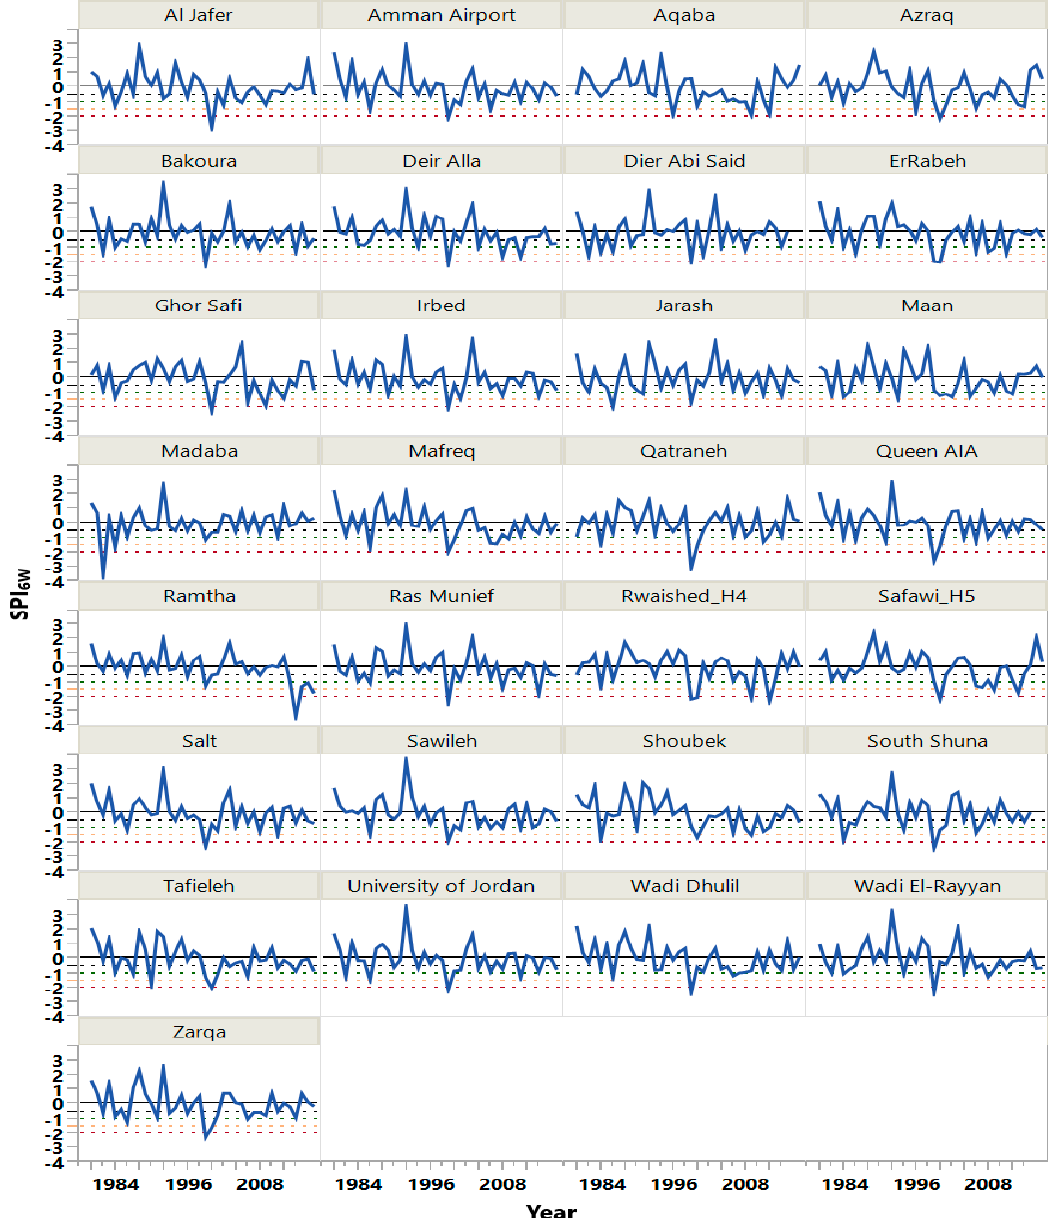
Figure 6. Wet season standardized precipitation index (SPI 6W ) values for each station 1980–2017.